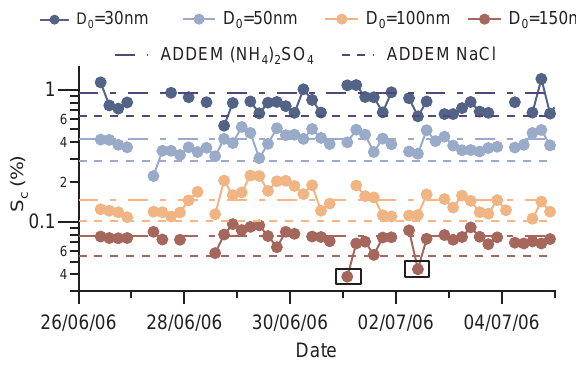
Fig. 14. Time series of D 50 at 0.08, 0.18, 0.37 and 0.62 %S mea- sured during the MAP campaign. The dashed lines show the theo- retical D 50 at each of the supersaturations for ammonium sulphate and sodium chloride.